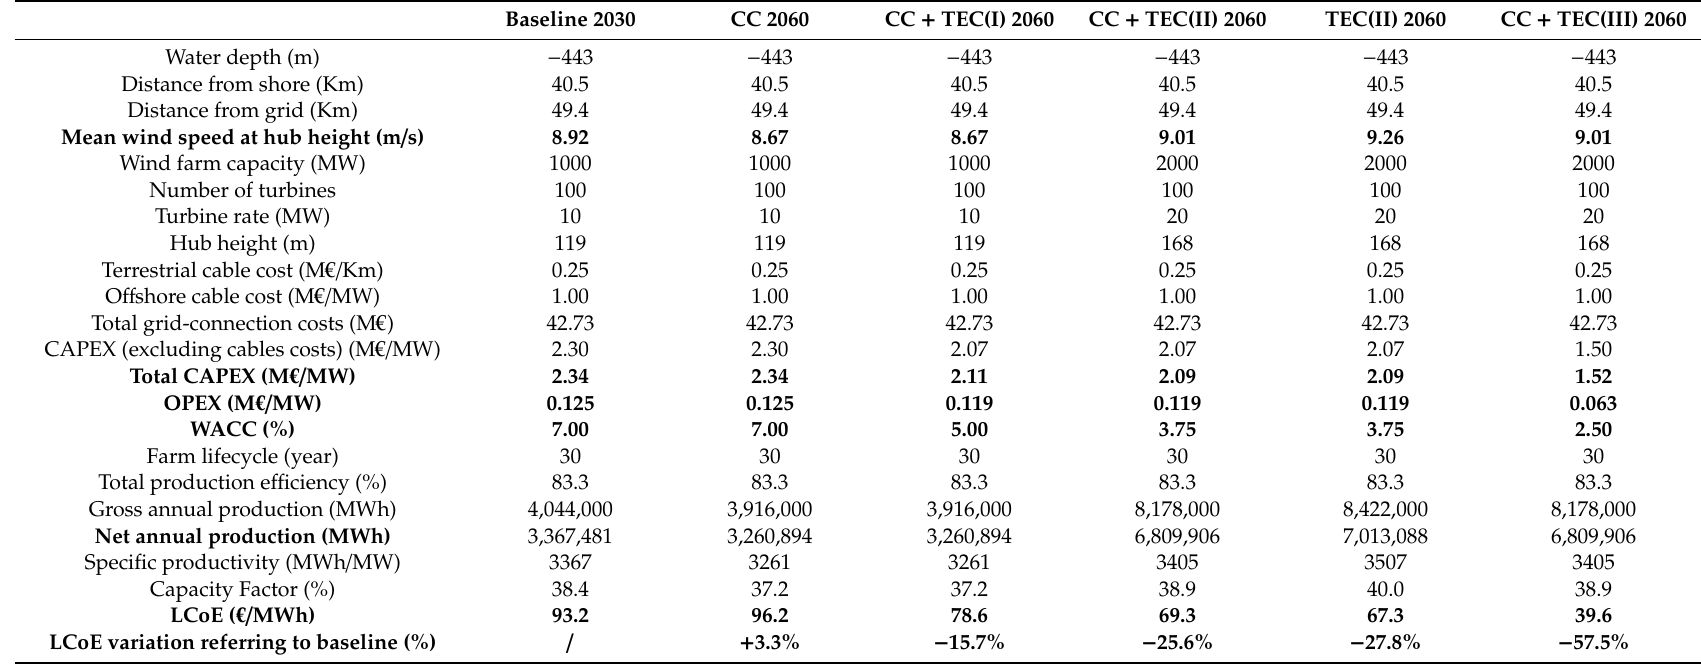
Table 8. Case study 3 (Sardinia); net wind speed variation: − 0.25 m / s. (Variable parameters in